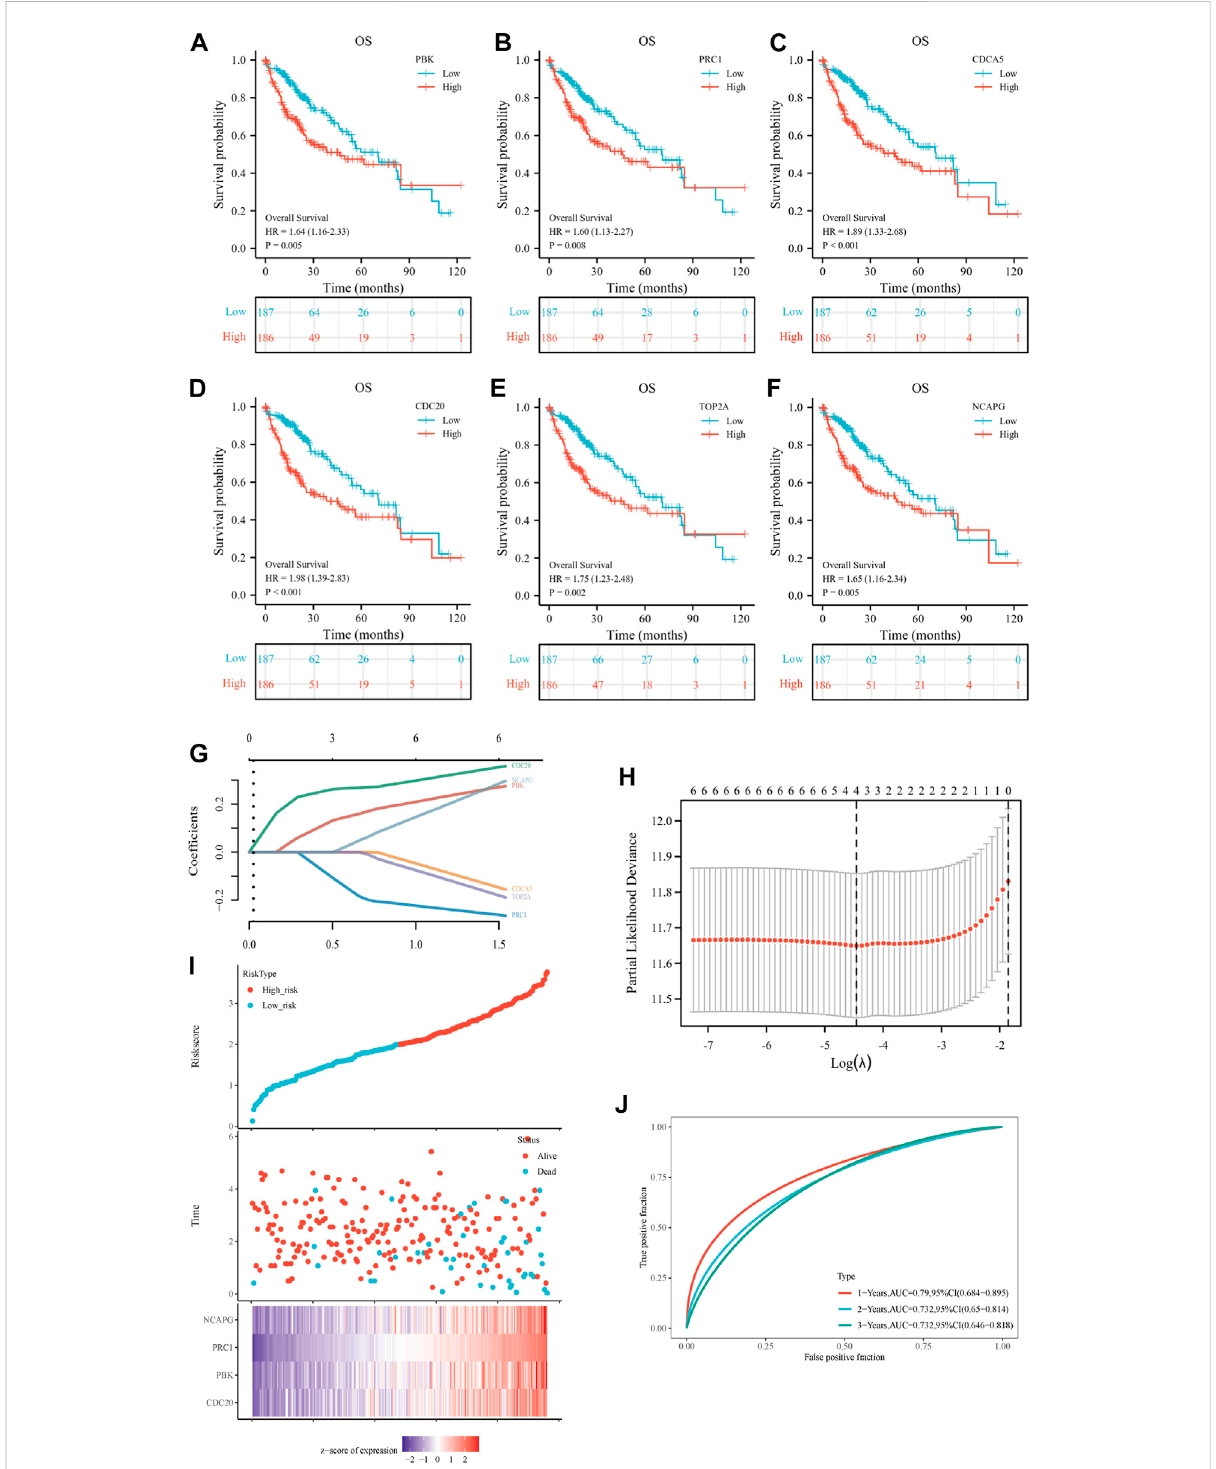
FIGURE 6 Prognosticgenesignatureofsixup-regulatedcoregenesinHCCpatients. (A – F) Associationbetween PBK (A) , PRC1 (B) , CDCA5 (C) , CDC20 (D) , TOP2A (E) ,and NCAPG (F) expressionandoverallsurvival(OS)wereperformedwiththeonlineKaplan – Meiersurvivalanalysis(KMplot,http://kmplot. com/analysis/). (G) The calculation of the regression coef fi cient. (H) LASSO Cox regression model of the six hub genes. (I) The risk score, survival time, and survival status of the selected dataset. The top scatterplot represents the risk score from low to high. The scatter plot distribution representstheriskscore ofdifferentsamplescorrespondingto thesurvivaltimeand survivalstatus. Thebuttonheatmapisthegeneexpression from the signature. (J) The ROC curve and AUC of the model. The higher values of AUC correspond to higher predictive